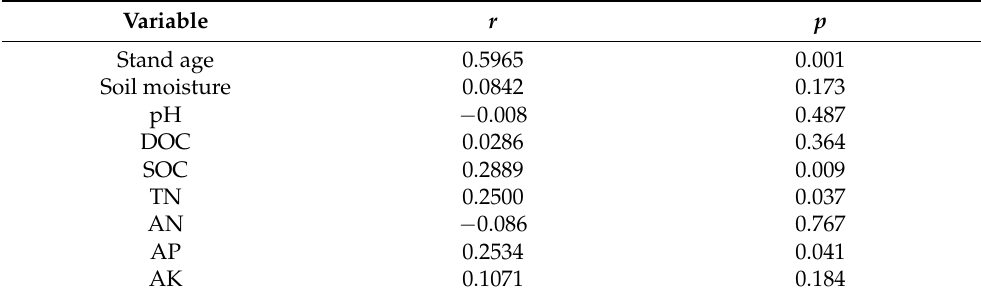
Table 2. Correlation between AM fungal community composition and environmental variables measured by Mantel test. Variable r p Stand age 0.5965 0.001 0.0842